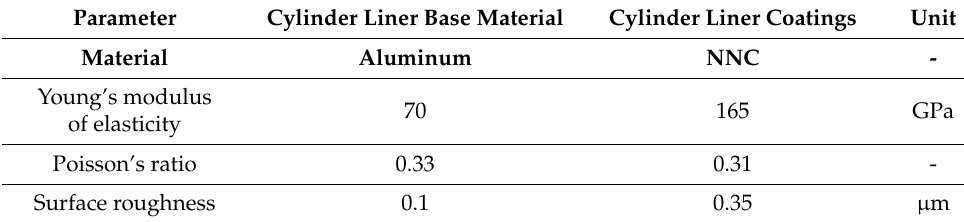
Table 5. Coating properties and surface topographical parameters for cylinder